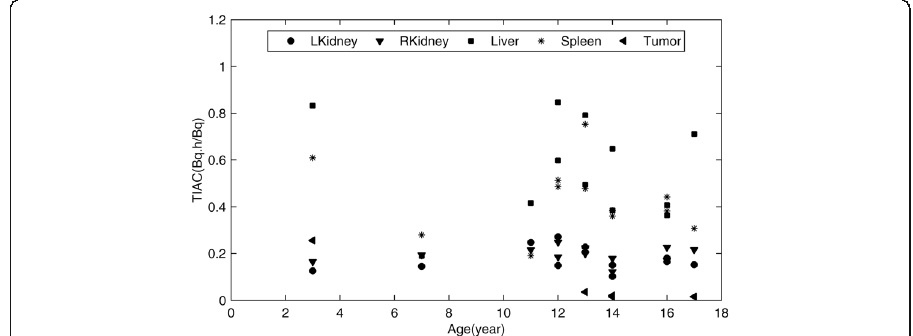
Fig. 4 Organ and tumor TIACs displayed versus patient age. Symbols represent different organs and tumors, including the left and right kidneys, liver, spleen, and